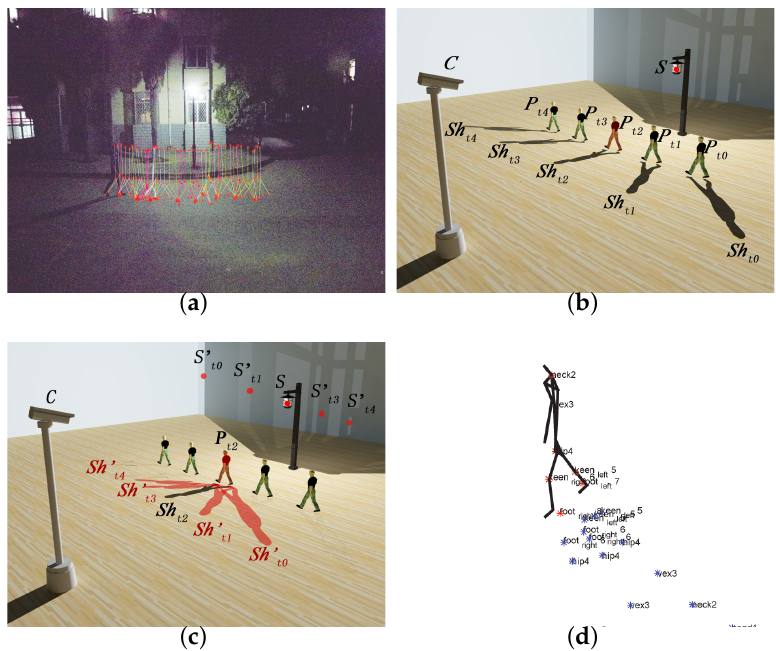
Figure 4. Demo of SSSE procedure in a single light source scenario. ( a ) Pose classification based on major joint positions; ( b ) Spatial–temporal discrete human poses belonging to same class; ( c ) Temporal–spatial aggregation; ( d ) Three-dimensional (3D) human